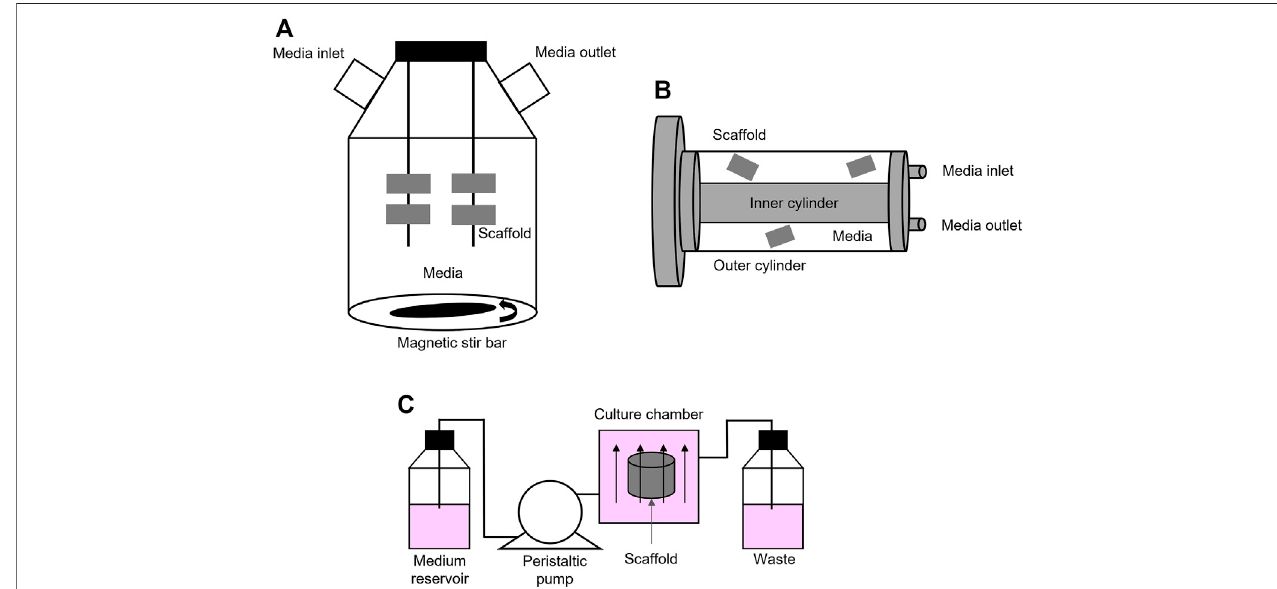
FIGURE 1 | Bioreactors: (A) Schematic representation of a spinner fl ask bioreactor. Bone scaffolds are suspended in stirred circulating media; (B) Schematic representation ofa rotating bioreactor. Outer cylinder motion allows the circulation ofmedia; (C) Schematic representation of abasic perfusion bioreactor system that is formed by a culture media reservoir, a peristaltic pump, a culture chamber, and waste.